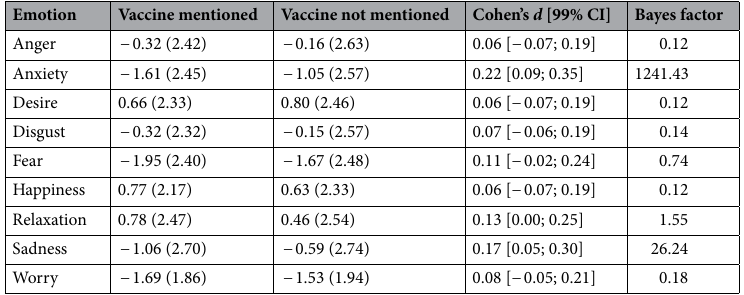
Table 9. Mean (SD) emotion change depending on whether participants mentioned the vaccine in phase 2. Negative change values indicate that the value of the emotion went down in phase 2 compared to phase 1. Vice versa for positive values. Values of zero imply no